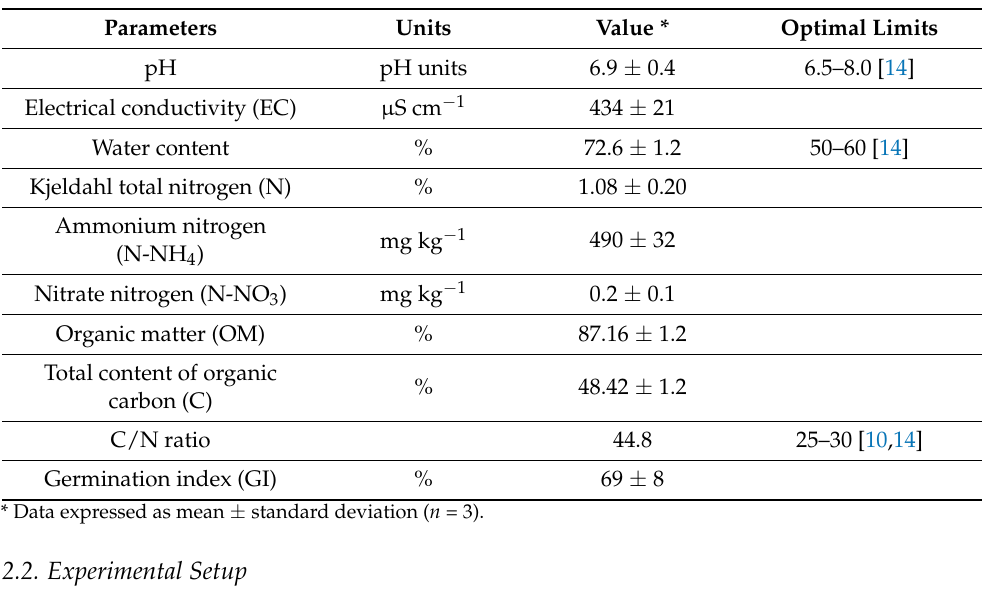
Table 1. The physicochemical parameters of mixed food and agricultural waste with an 85:15 raw weight ratio.